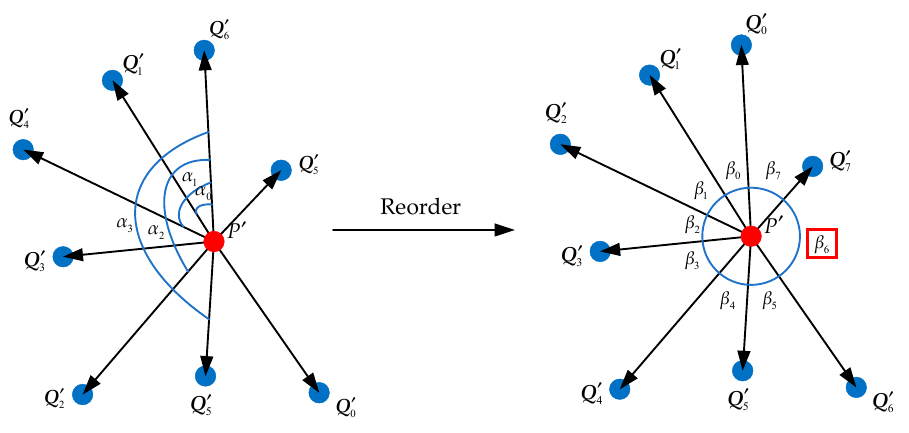
Figure 4. Maximum angle measurement criterion.